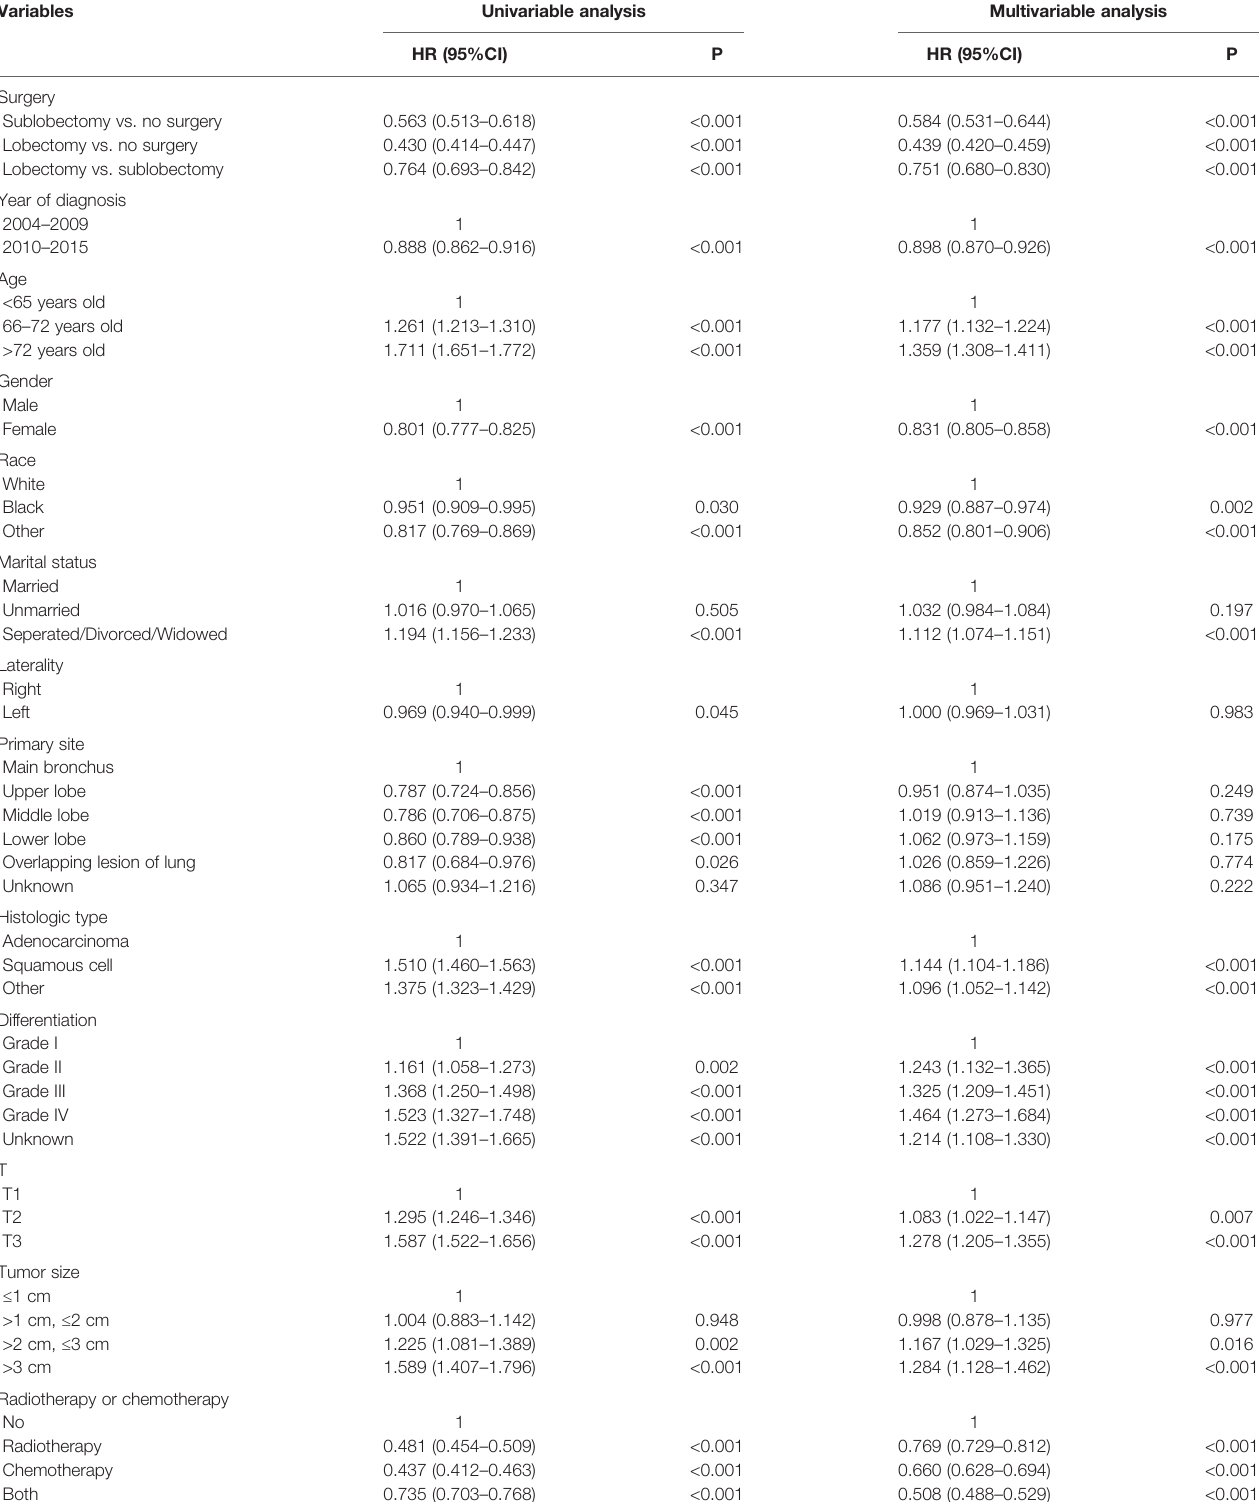
TABLE 2 | Cox regression analysis of all IIIAN2 stage NSCLC patients before